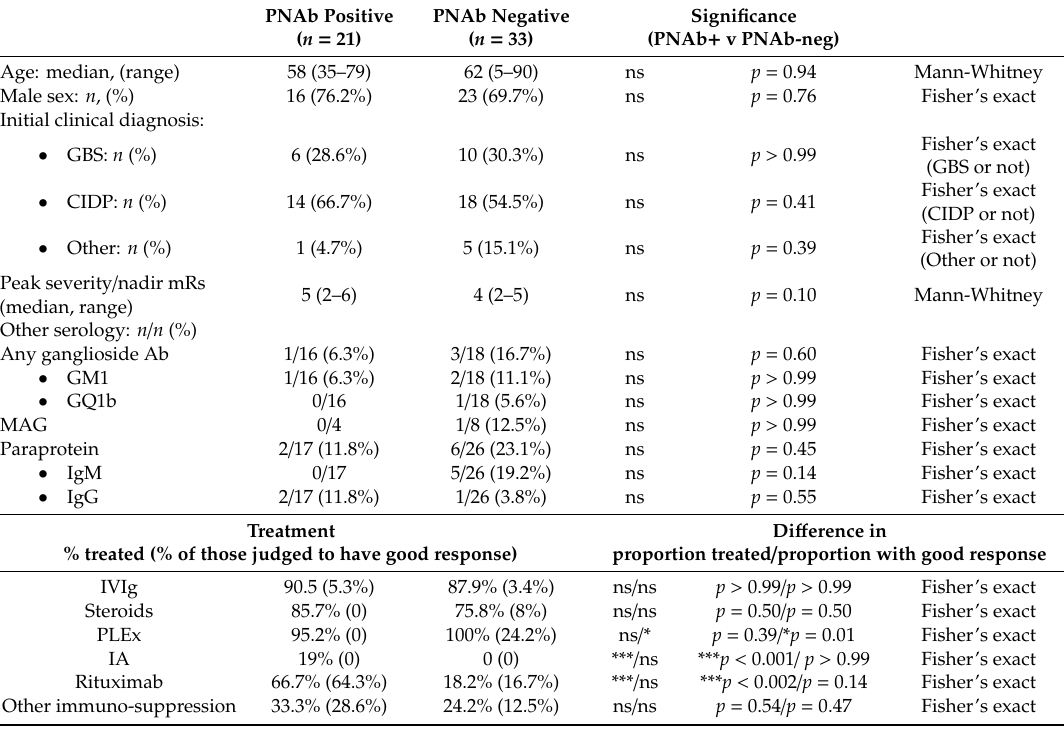
Table 1. Summary characteristics of apheresis treated patients from the PNAb